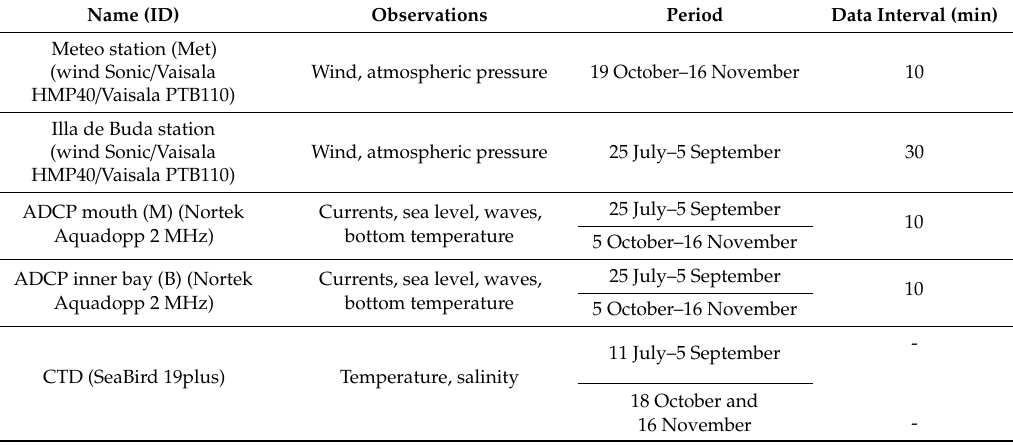
Table 1. Data acquisition instruments and observational periods (year 2017) shown in Figure